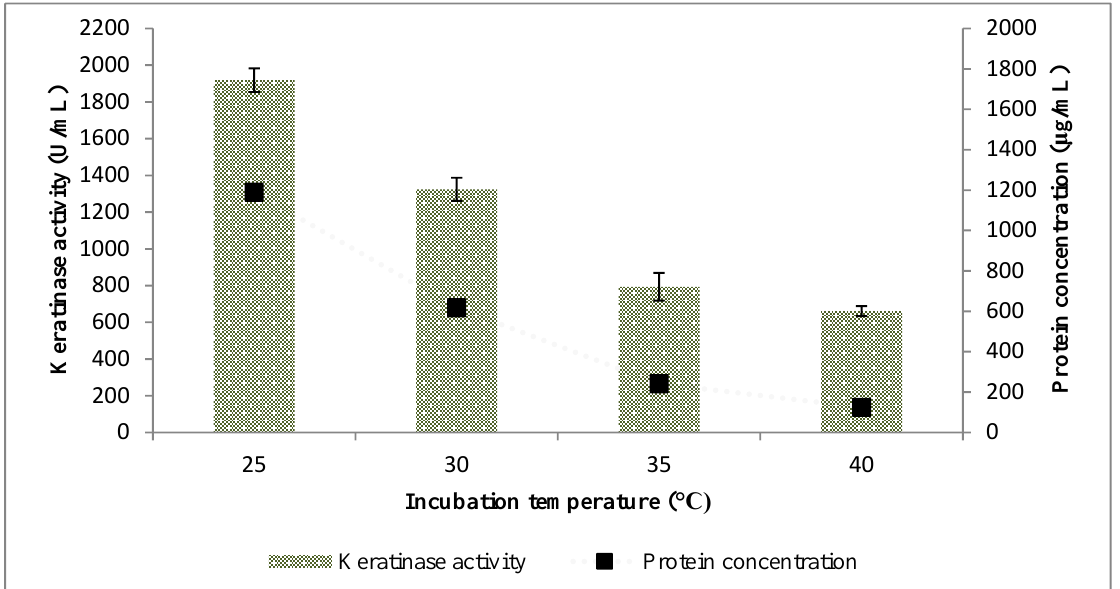
Figure 7. The effect of incubation temperature on keratinase activity by Bacillus sp. FPF-1. Figure 7. The e ff ect of incubation temperature on keratinase activity by Bacillus sp. FPF-1.